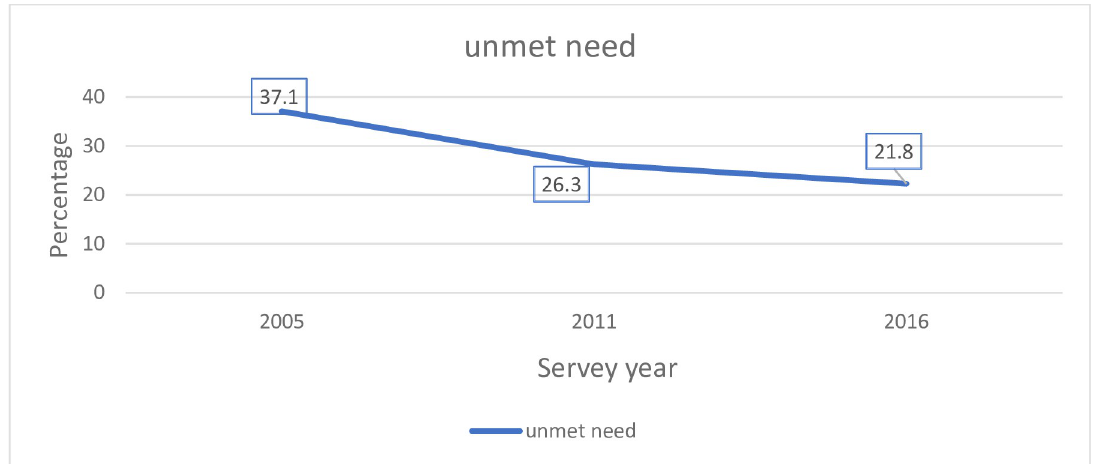
Fig 2. Trends of unmet need for family planning during the three consecutive DHS surveys in Ethiopia.